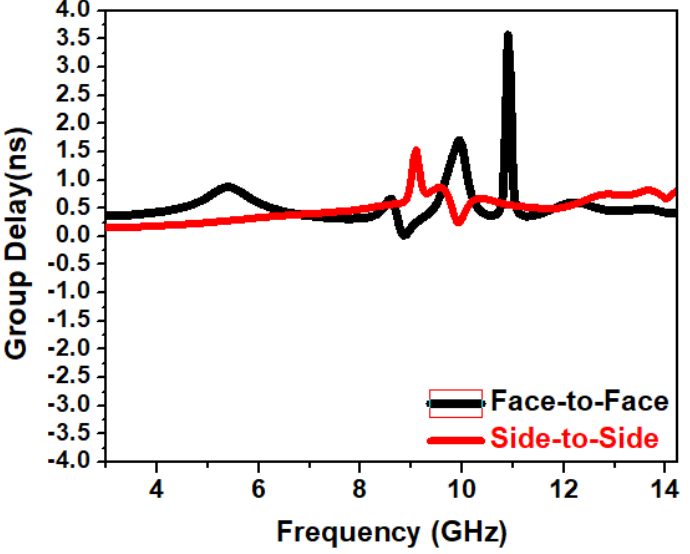
Figure 37. Analysis in time-domain with ( a ) frontal and ( b ) lateral orientations. Figure 38 shows that the group delay is almost linear for both frontal and lateral orientations, except in the notch bands.